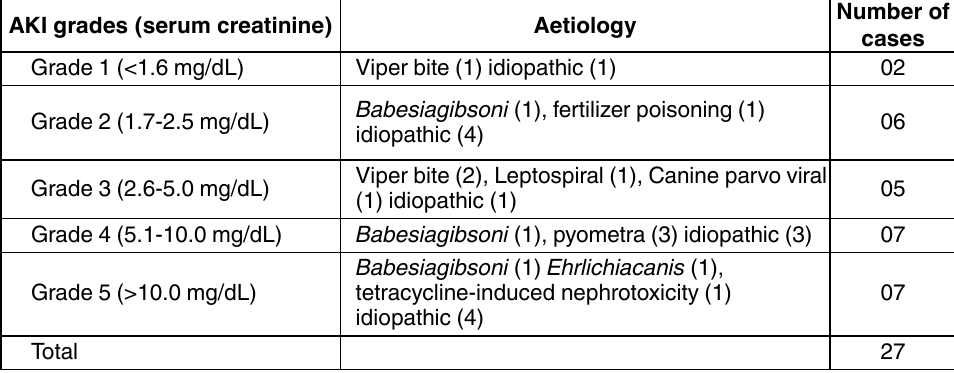
table 1. Grading of acute kidney injury aKi grades (serum creatinine)